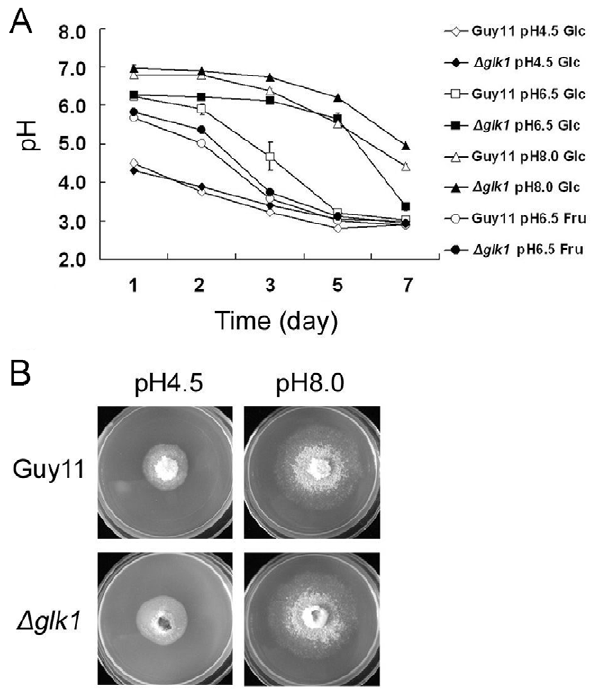
Figure 2. The D Moglk1 mutants show reduced acidification on ammonium and glucose containing medium. (A) The effects of different sugars (1% glucose, or 1% fructose) and medium pH (4.5, 6.5, or 8.0) on extracellular acidification. The extracellular pH was measured in liquid cultures of wild type Guy11 and D Moglk1 strains grown in the presence of 100 mM ammonium for various times, as indicated (days). The experiments were performed in six independent replicates. Error bars show the standard deviation of the mean for six replicates. (B) Guy11 and D Moglk1 mutants were grown on MM containing 1% glucose and 100 mM ammonium agar plates with initial pH 4.5 or pH 8.0. Photographs were taken at 9 days after incubation at 30 u C. The experiments were performed in triplicate.